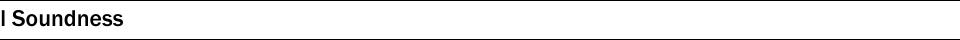
Table 1. Criteria for Evaluating Case